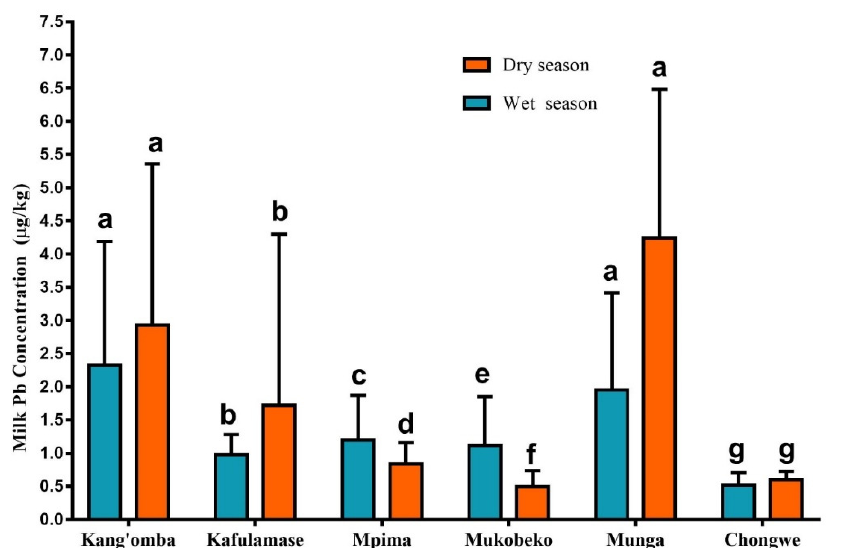
Figure 2. The variation of mean Pb concentration results in cow milk ( µ g/kg-wt./wt.) per region and per season. The lower-case letters a–g represent significant differences among the sampled regions using Tukey’s multiple comparison test set at 0.05 ( p < 0.05).